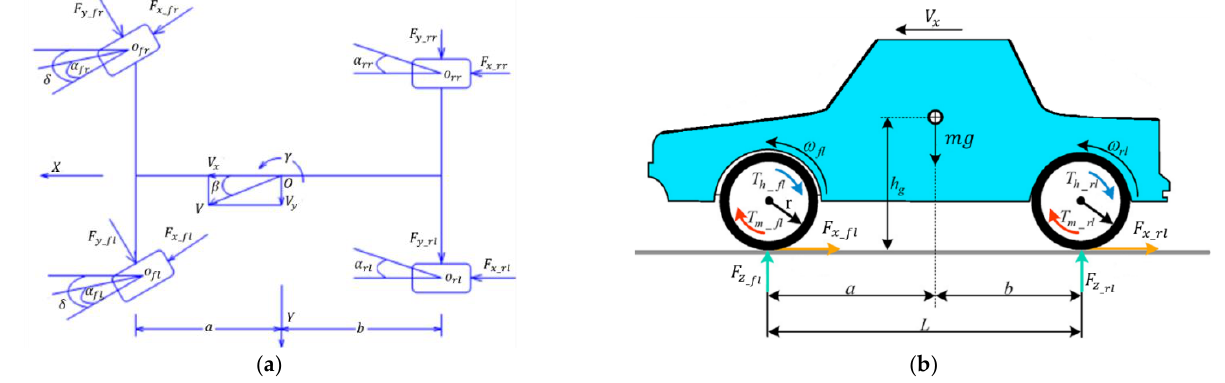
Figure 2. 7DOF 4WD BEV dynamic model: ( a ) Longitudinal and lateral force on 7DOF model; ( b ) The force and torques on left wheels. Table 1. DOF Definitions of 7DOF vehicle model.